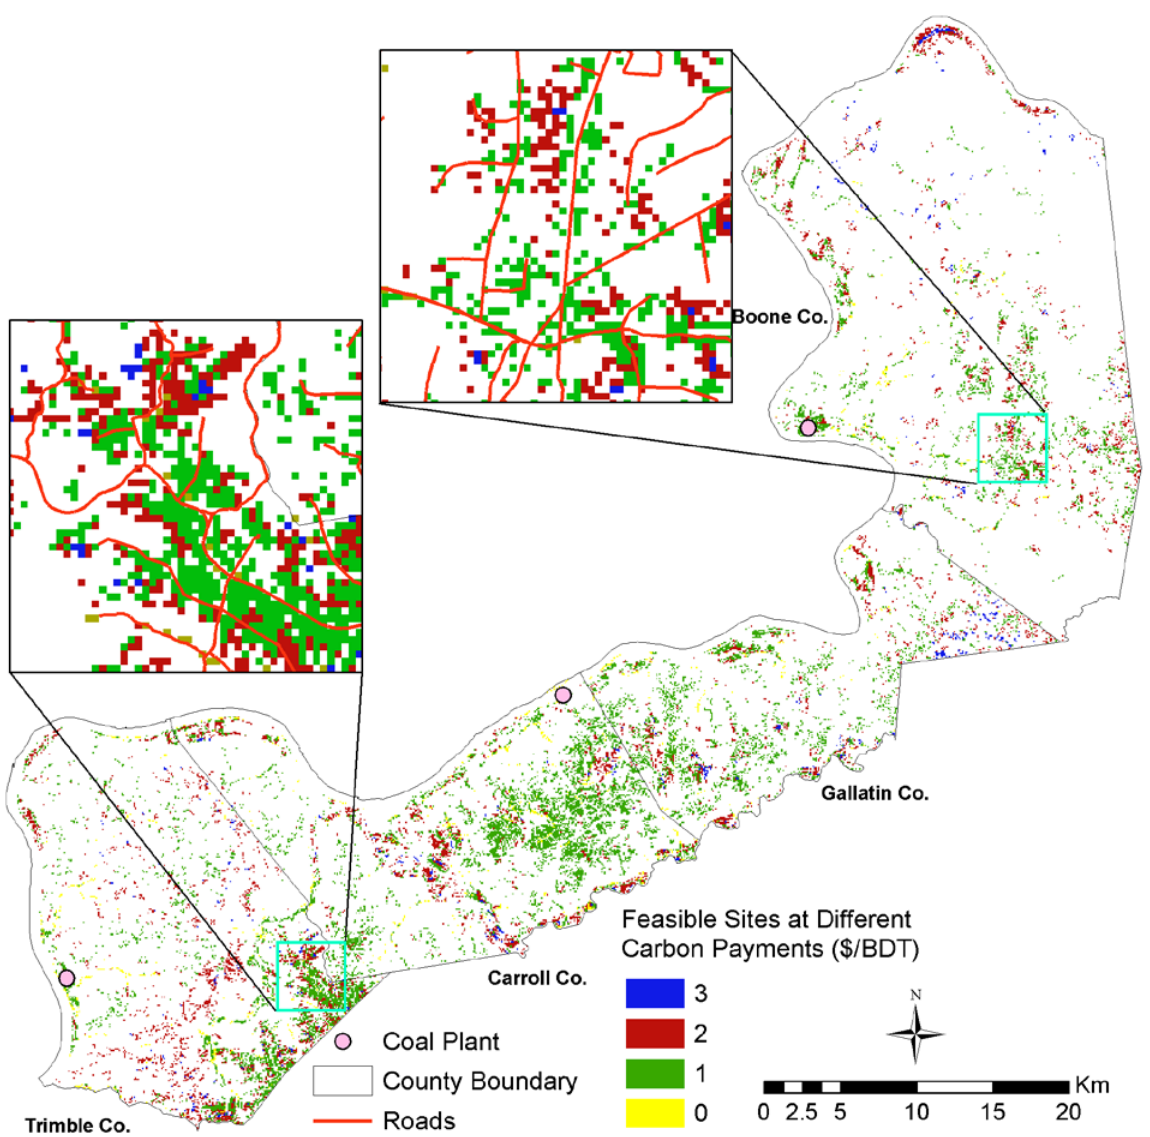
Figure 9. Spatial distribution of economically feasible sites for establishing sweetgum at different carbon offset